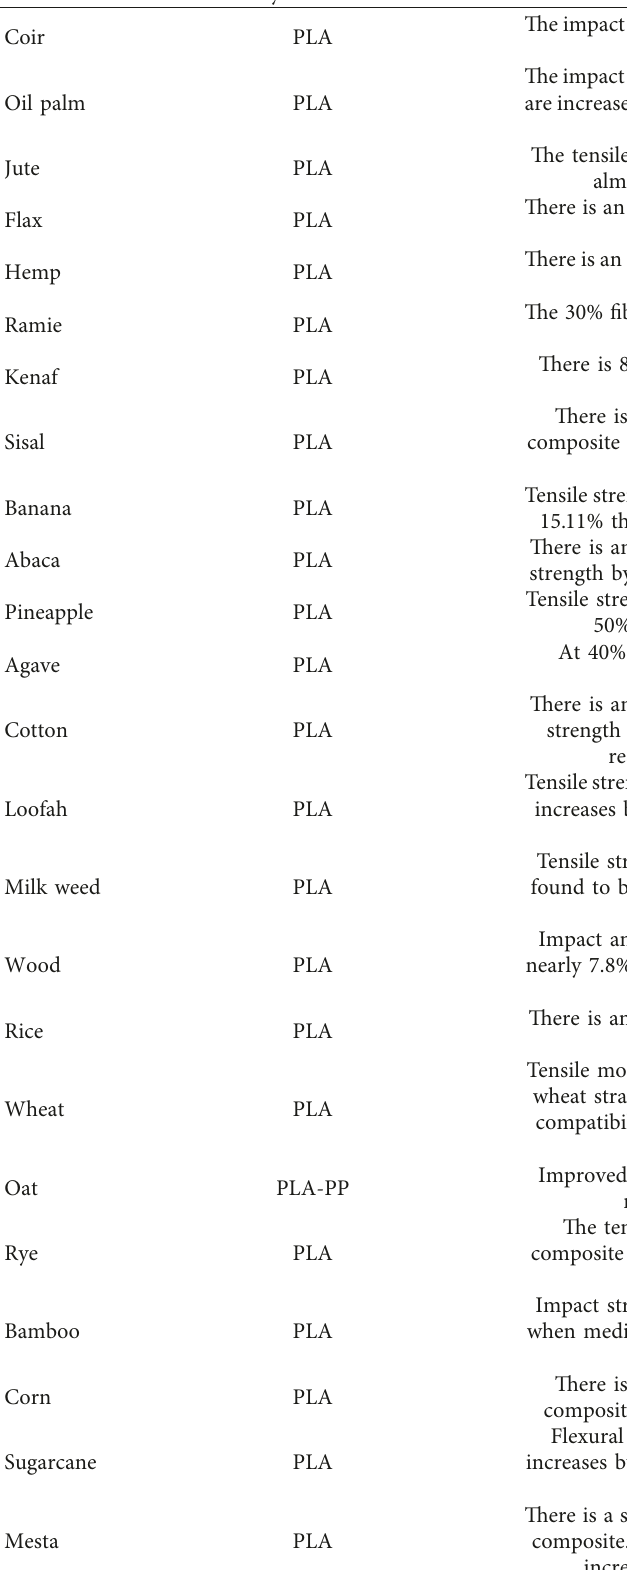
Table 12: Natural fibers with various polymer matrices and their resulting enhancement in mechanical properties.